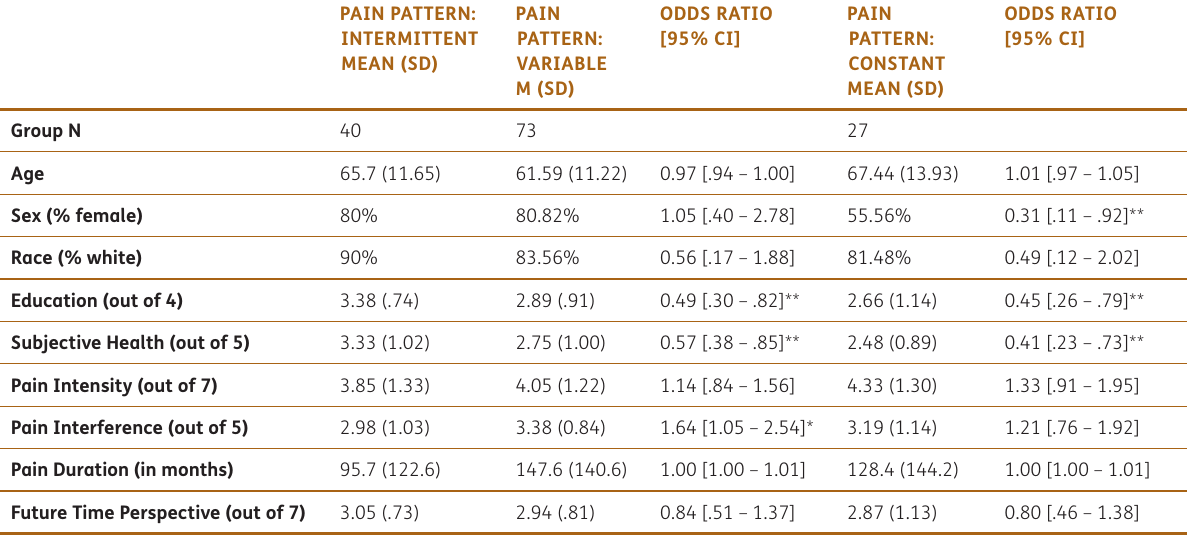
Table 2 Pain temporal pattern group compositions and results from bivariate logistic regressions using socio-demographic/health factors to predict pain pattern group status. Intermittent pain is the reference group. * p < .05, ** p <